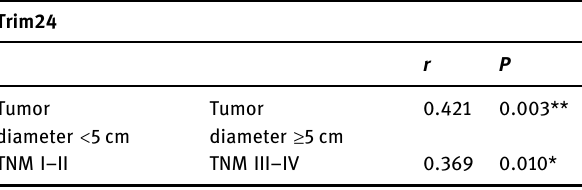
Table 4: The correlation between Trim24 expression and clinico - pathological features in renal cell